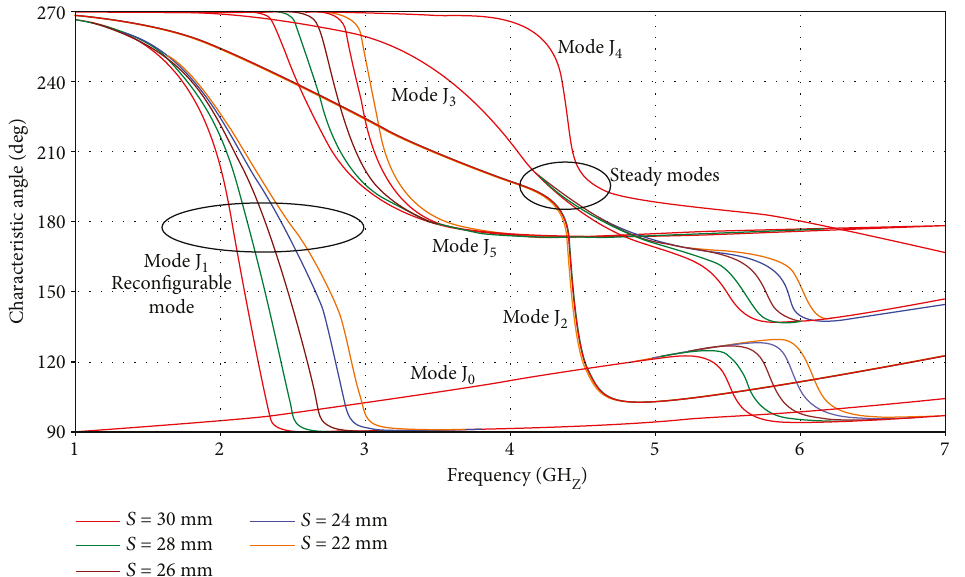
Figure 6: Characteristic angle variation with the slot length ( S ) for the fi rst six CM over frequency.